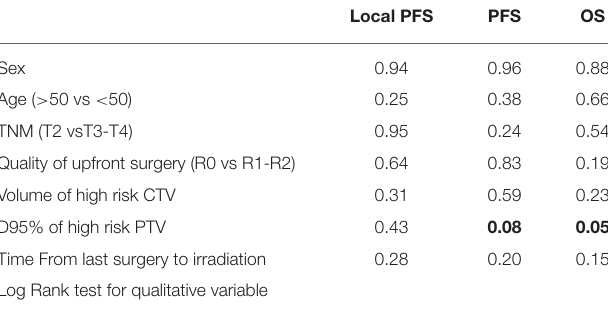
TABLE 3 | Prognostic factor (univariate analysis).